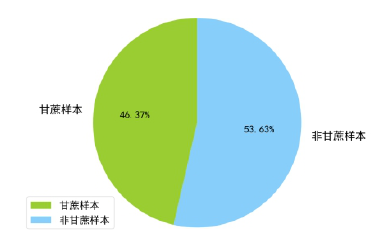
Figure 5. After Data augmentation Sugarcane sample statistics